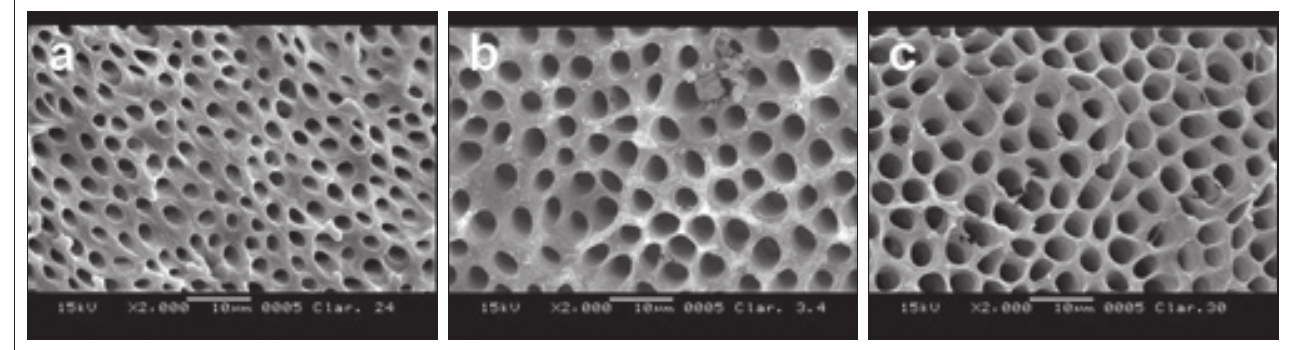
Figure 1. Scanning electron microscope micrographs representing score rates of dentin surface alterations. A: score 0 – absent morphological changes. B: score 1 – moderate morphological changes. C: score 2 – severe morphological